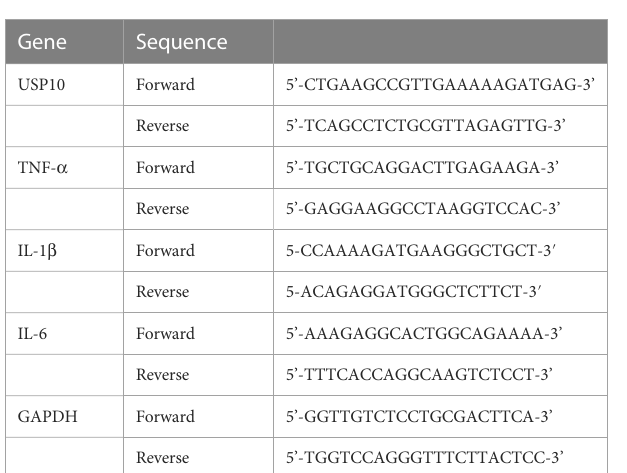
TABLE 1 List of primers for